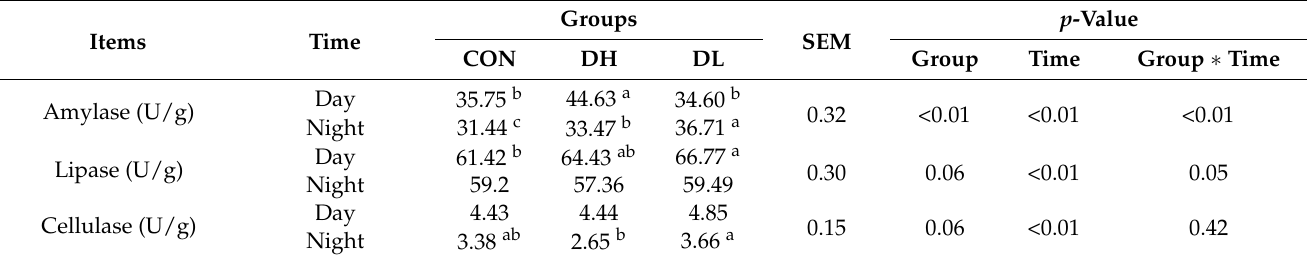
Table 5. Rumen digestive enzyme activity